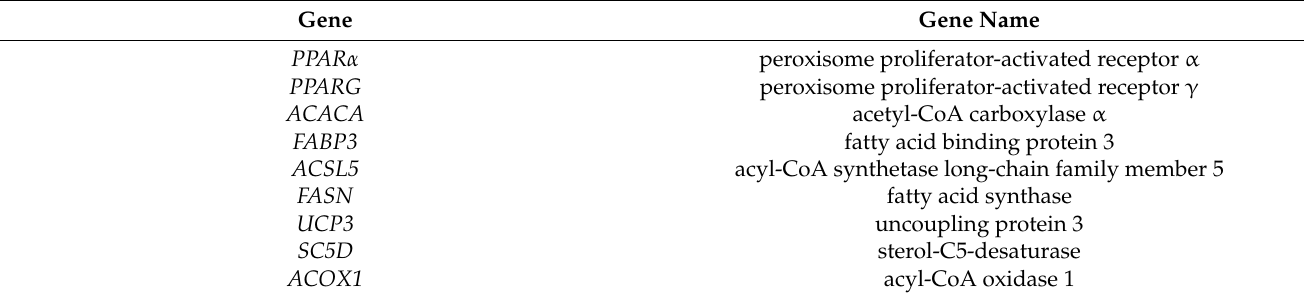
Table 11. Screening gene